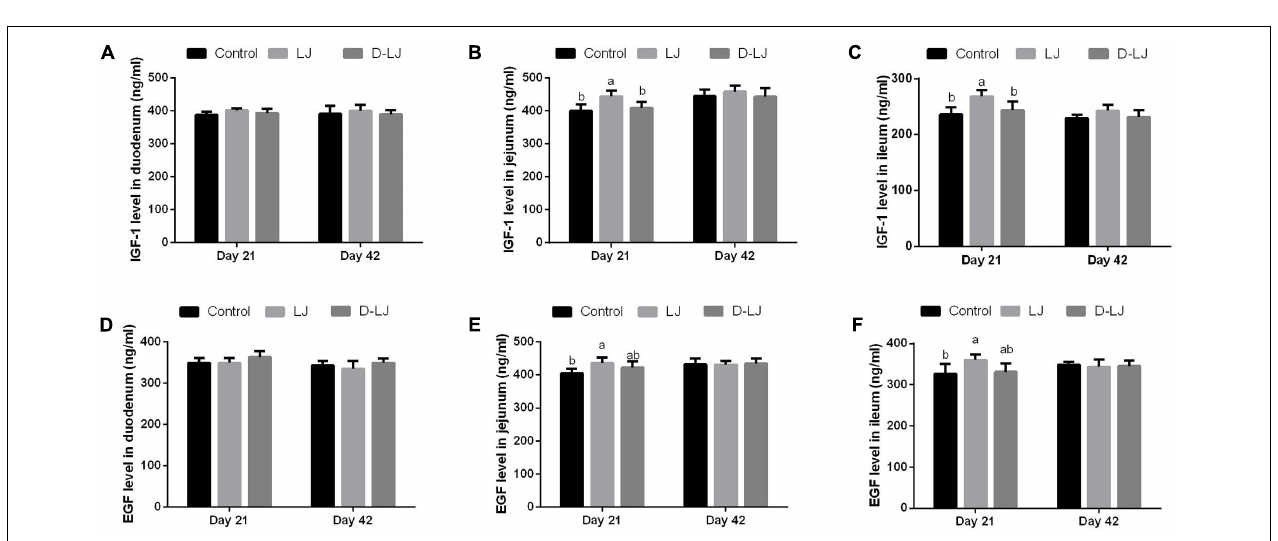
FIGURE 5 | Levels of insulin-like growth factor-1 (IGF-1) and epidermal growth factor (EGF) in the small intestine. Bars with different letters are significantly different on the basis of Duncan’s multiple range tests ( P < 0.05). Data are presented as mean ± standard deviation (six replicates of one chick per cage). (A–C) IGF-1 levels in the duodenum, jejunum, and ileum; (D–F) EGF levels in the duodenum, jejunum, and ileum.